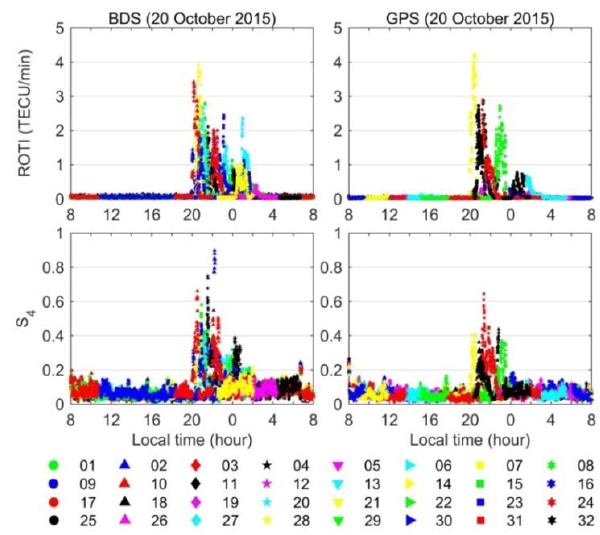
Figure 1. Time series of the rate of TEC index (ROTI) and S 4 of di ff erent BDS and GPS satellites observed at Hong Kong Sha Tin (HKST) station on 20 October 2015 (day of year (DOY) 293). Di ff erent satellite pseudorandom noise (PRN) is represented by the di ff erent color or symbol as shown in the bottom side. Statistical results of BDS scintillation in spring (March–May) and autumn (September–November)